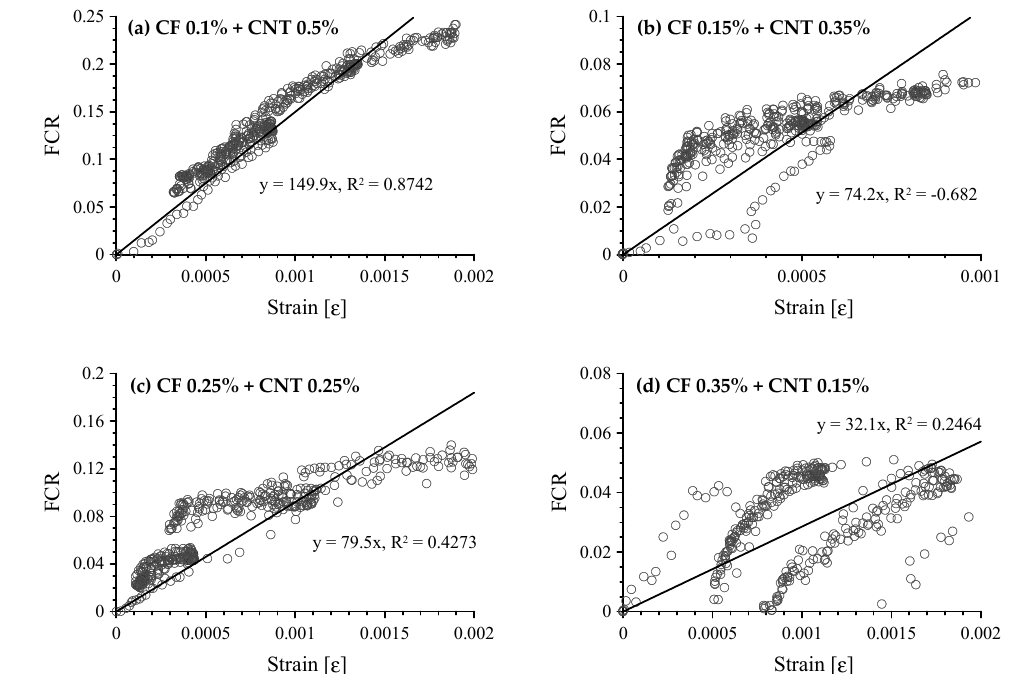
Figure 15. Correlation between FCR and compressive strain of cement-based composites with both CFs and MWCNTs; ( a ) composites with 0.1 vol.% CFs and 0.5 vol.% MWCNTs; ( b ) composites with 0.15 vol.% CFs and 0.35 vol.% MWCNTs; ( c ) composites with 0.25 vol.% CFs and 0.25 vol.% MWCNTs; and ( d ) composites with 0.35 vol.% CFs and 0.15 vol.% MWCNTs.